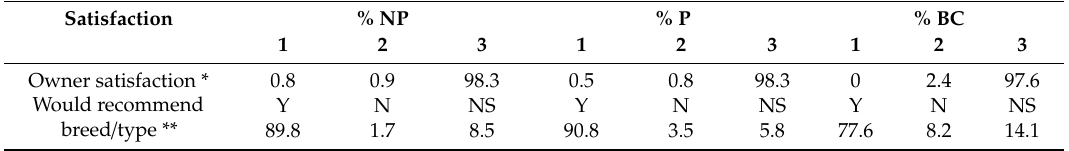
Table 6. Owners’ satisfaction with their cat by breed /